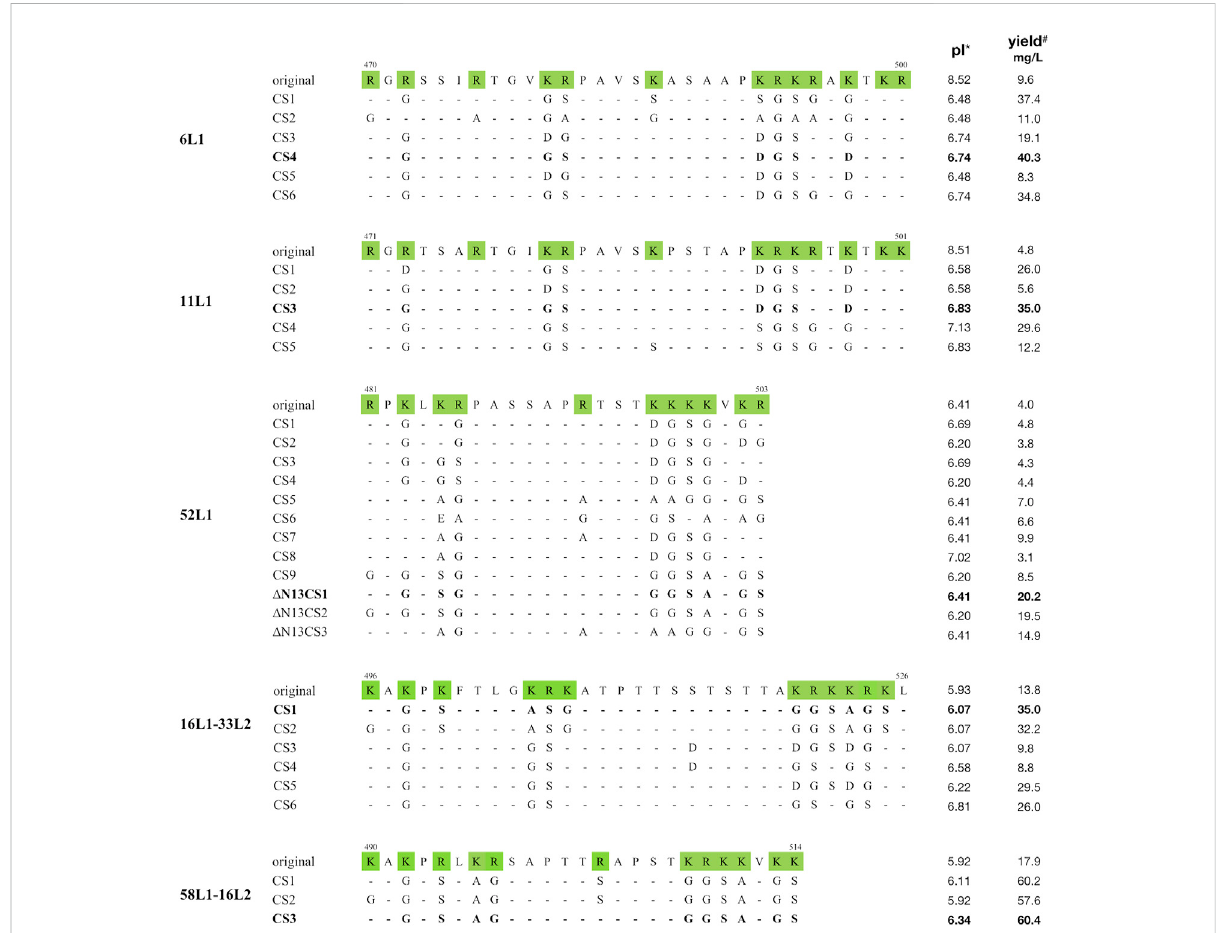
Alignment of C-terminal amino acid sequences of 6L1, 11L1, 52L1, 16L1-33L2, and 58L1-16L2. Amino acid numbers are shown on the top of each original sequence. Basic amino acids are shaded in green. Dashes indicate consensus amino acids compared to corresponding original sequences. The mutants with maximal yields of each type are bolded. *: Isoelectric point. # : The mean yields of three biological